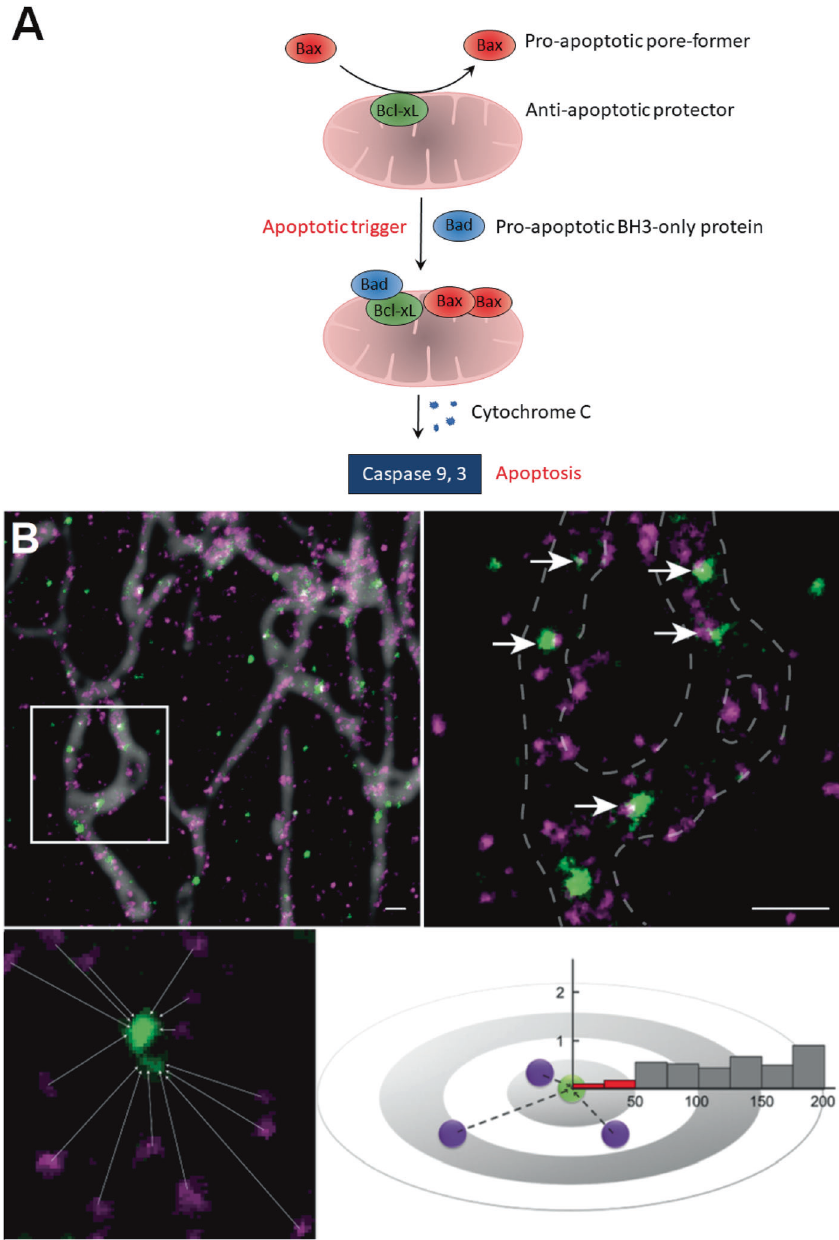
Fig. 1 Schematic diagram of the apoptotic process and illustration of nearest neighbor analysis. A Schematic illustration of the apoptotic process governed by Bad, Bcl-xL, and Bax. All Bcl-2 family proteins contain at least one of the four Bcl-2 homology motifs (BH1 – 4), which are essential for their function. Pro-apoptotic BH3-only proteins (e.g., Bad, Bid, and Bik) only contain the BH3 domain, while pro-apoptotic pore- forming (Bax and Bak) and anti-apoptotic (Bcl-2, Bcl-xL, Bcl-w, Mcl-1, and B fl -1/A1) proteins contain all four BH domains and are referred to as multi-domain proteins. In response to apoptotic stimuli, the BH3 domain of pro-apoptotic BH3-only proteins (Bad) binds to the BH3 domain- binding groove of anti-apoptotic Bcl-2 proteins (Bcl-xL). This disrupts binding between anti-apoptotic and pore-forming (Bax) proteins, causing activation of the pore-forming protein. Certain BH3-only proteins (Bid and Bim) can also induce apoptosis by directly binding to and activating pore-forming proteins on the outer mitochondrial membrane [15]. The point of no return in the apoptotic process occurs when apoptotic pore-forming proteins have accumulated on mitochondria and permeabilized the outer mitochondrial membrane, leading to the release of cytochrome c and activation of caspases present in the cytoplasm [19]. B Illustration of nearest neighbor analysis. The distances between two proteins, Bad (green) and Bcl-xL (magenta) in this example, are measured by super-resolution stimulated emission depletion (STED) microscopy and summarized in a histogram. The <50 nm distance fraction (red) between two species is indicative of molecular interaction. Scale bars = 500